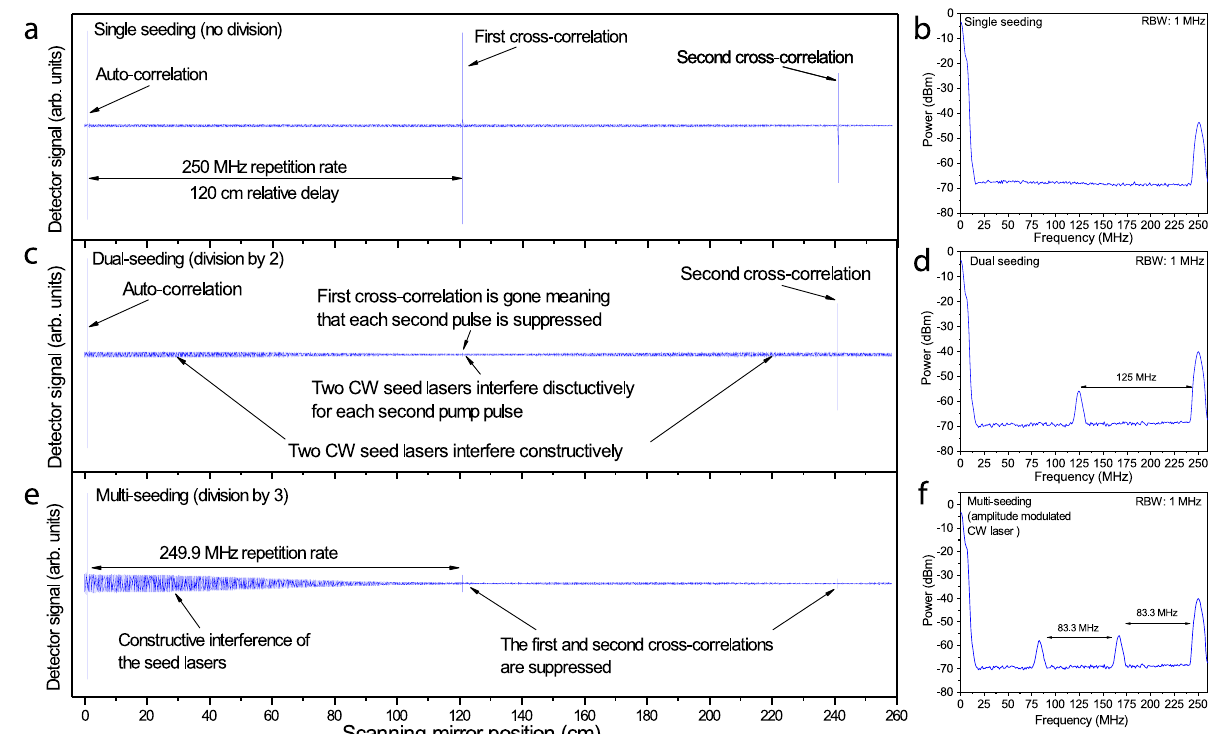
Fig. 3. (a) Interferogram in the case of single CW-seeded OPG; (b) RF spectrum of the signal/idler repetition rate for (a): (c) Interferogram for dual CW-seeded OPG corresponding to repetition rate division by a factor of 2; (d) RF spectrum of the signal/idler repetition rate for (c); (e) Interferogram for multi (one CW laser is amplitude modulated) CW-seeded OPG corresponding to repetition rate division by a factor of 3; (f) RF spectrum of the signal/idler repetition rate for